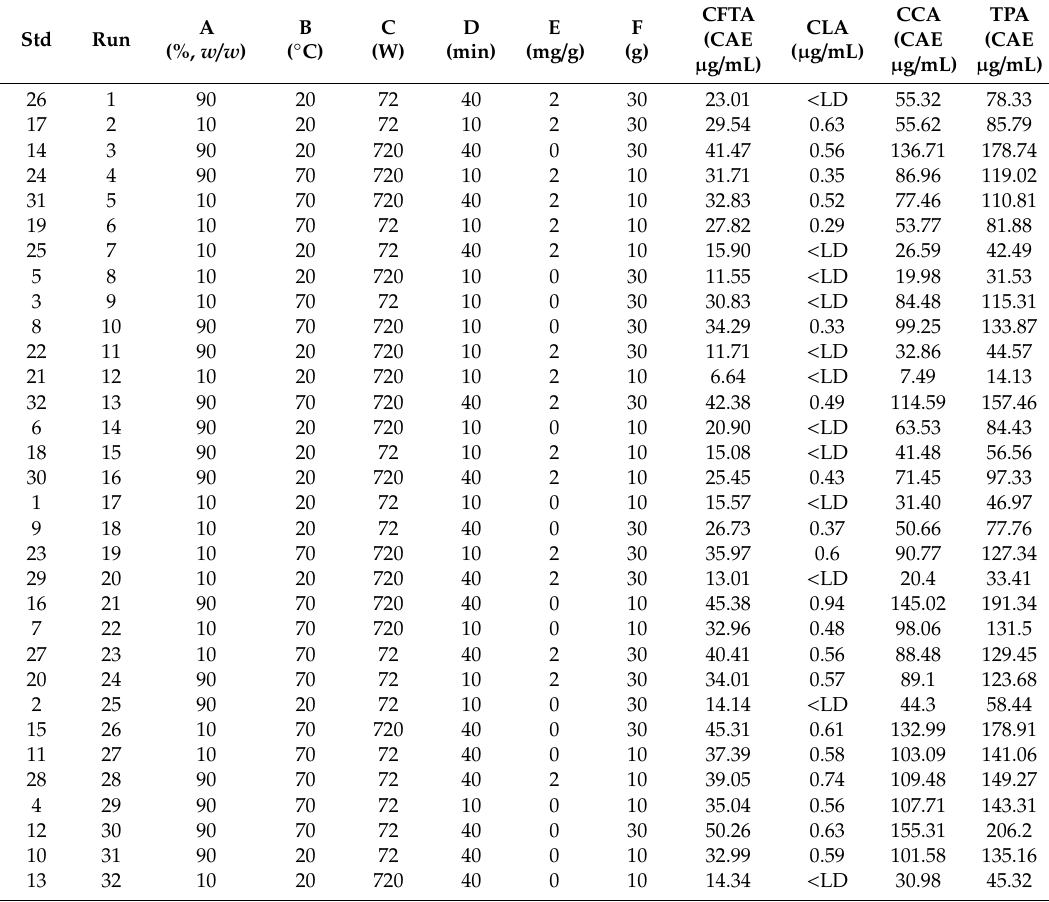
Table3. Independentvariables, theirlevelsforthetwo-levelfactorialdesign,